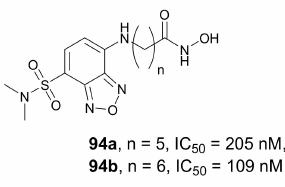
Figure 32. Chemical structures of compounds 94a and 94b